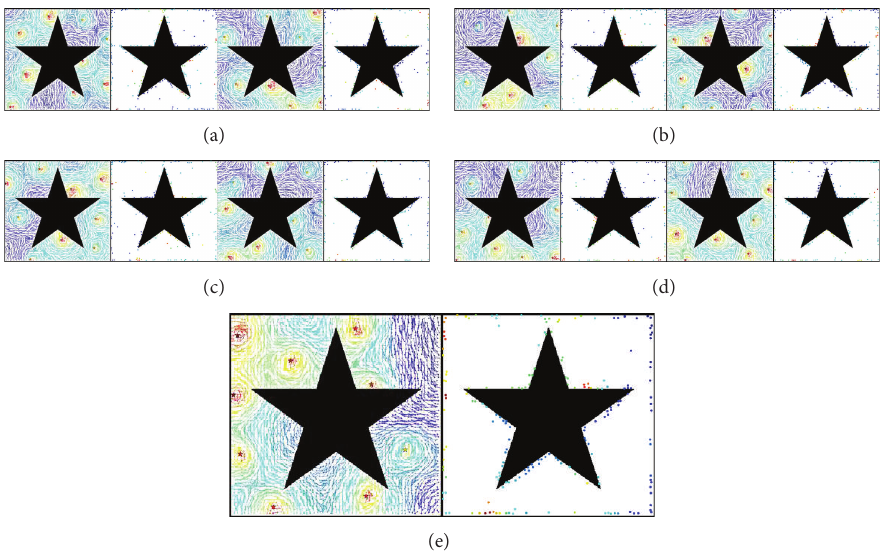
Figure 7: Semi-iso-contours and their end points of the other 9 types of virtual gas.